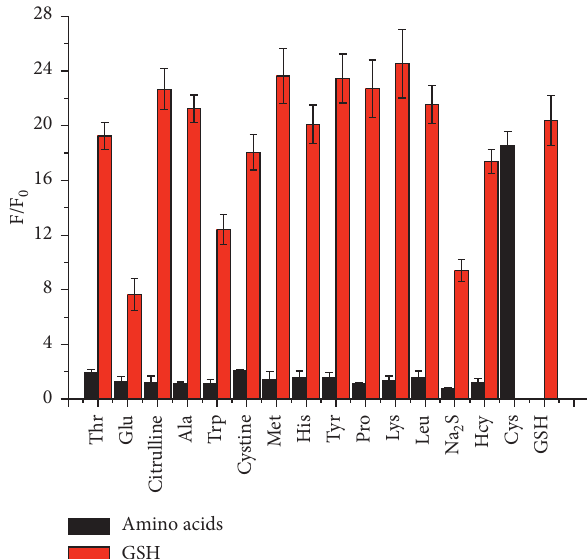
Figure 3: Fluorescence responses of KL-DN (10 μ M) to different amino acids (20 μ M) (blank bar) in DMSO/PBS buffer (1:1, v/v, 10mM, pH 7.4), λ ex � 310nm. Red bars represent the intensity with subsequent addition of GSH (20 μ